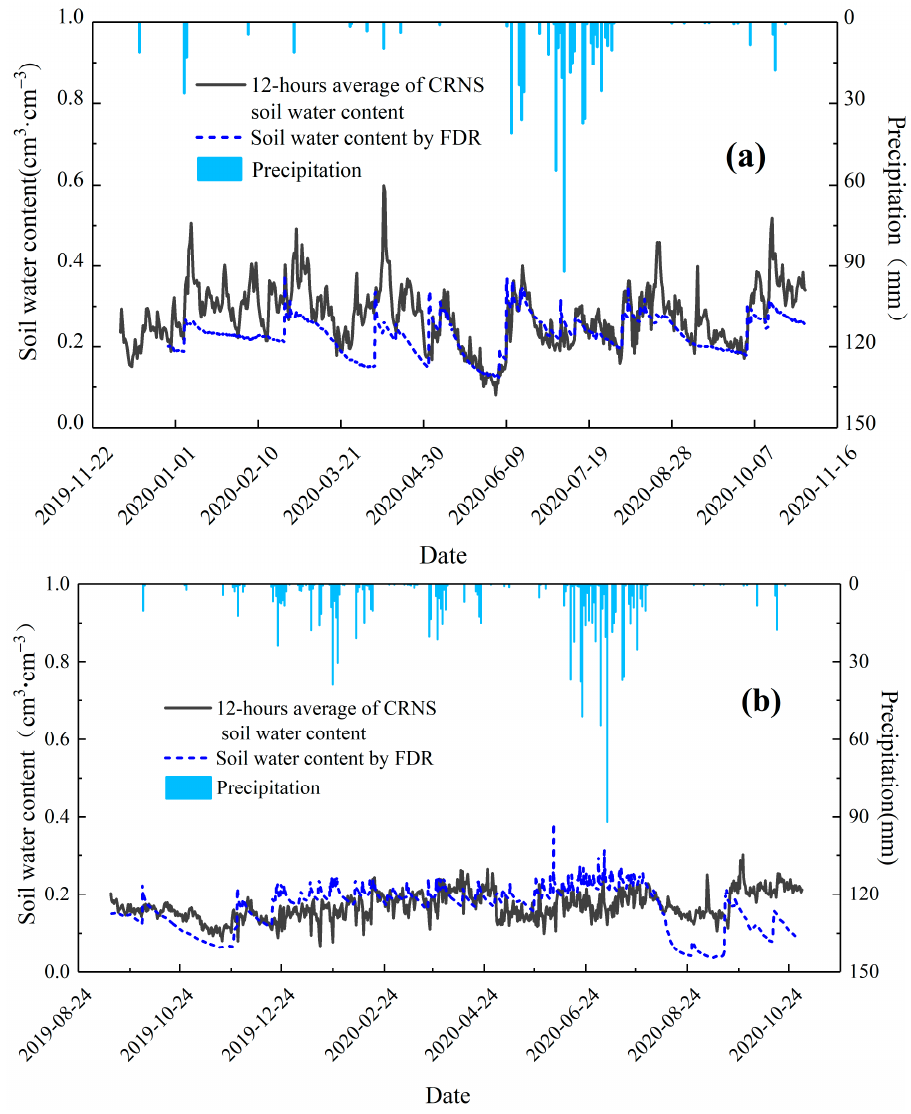
Figure 3. Comparison of SWC measured by the CRNS and the FDR at the Fengqiu station ( a ) and the Hemuqiao station ( b ). N 0 corresponds to the neutron count rate on 4 June 2020, at the Fengqiu station, while N 0 corresponds to the neutron count rate on 18 November 2019, at the Hemuqiao